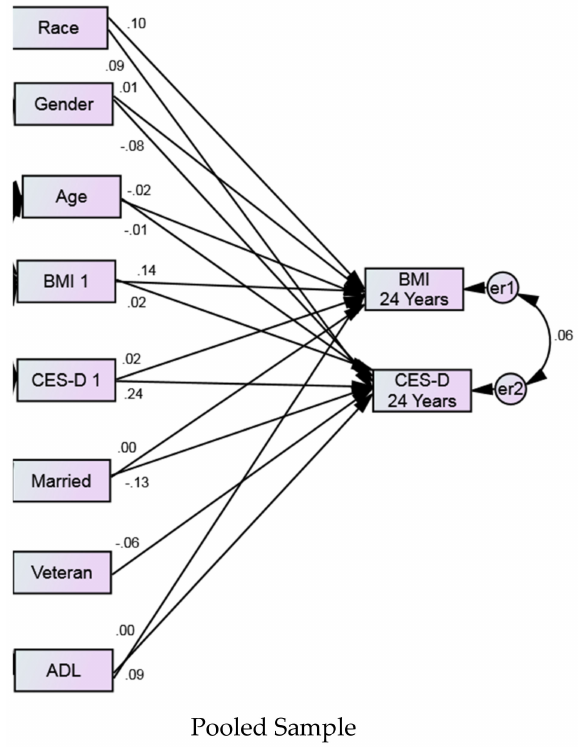
Figure 2. Structural equation model (SEM) in the pooled sample. Dependent variables: average depressive symptoms and BMI over 24 years. Independent variables: baseline depressive symptoms and BMI. Covariates: age, race, gender, marital status, veteran status, and ADL. Numbers reflect standardized adjusted path coefficients. Probability level = 0.274, Chi-square (CMIN) = 1.198, DF = 1, CMIN/DF = 1.198, CFI = 1.000, RMSEA = 0.002